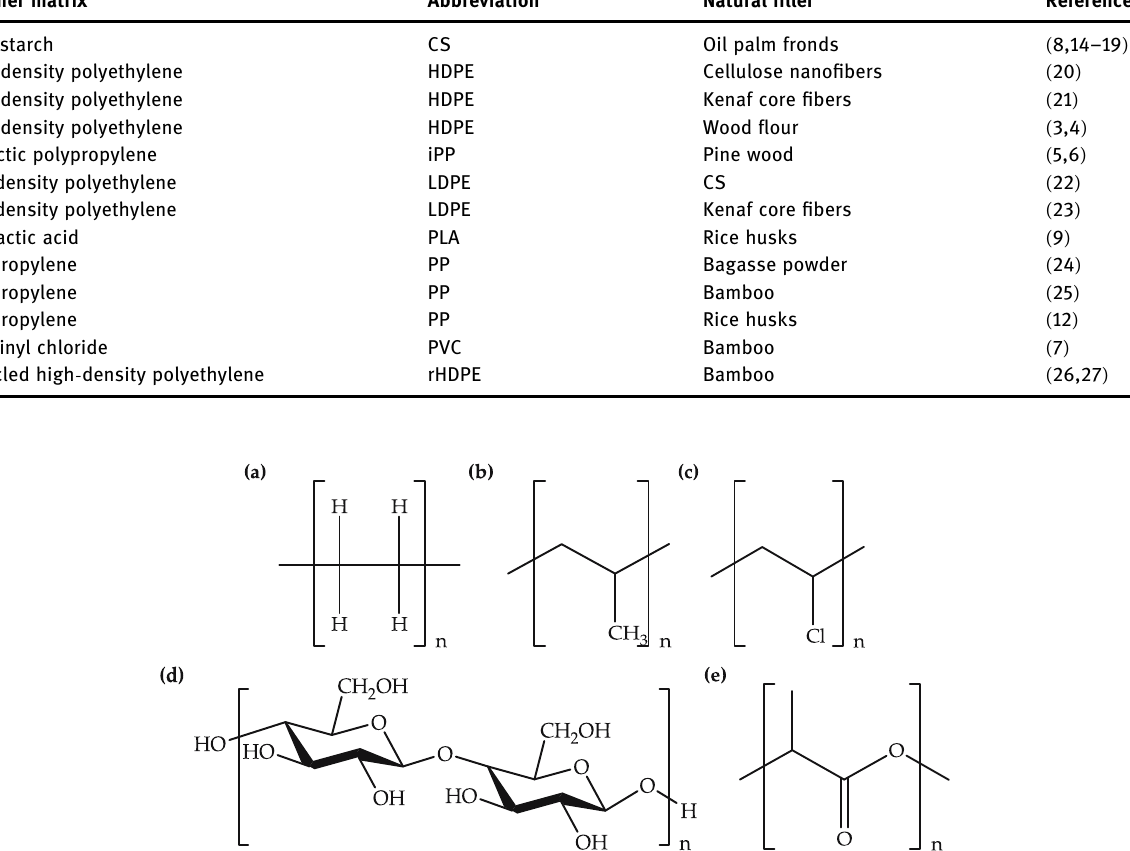
Table 1: Examples of polymer matrices and natural fi llers utilized for the fabrication of polymer biocomposites Polymer matrix